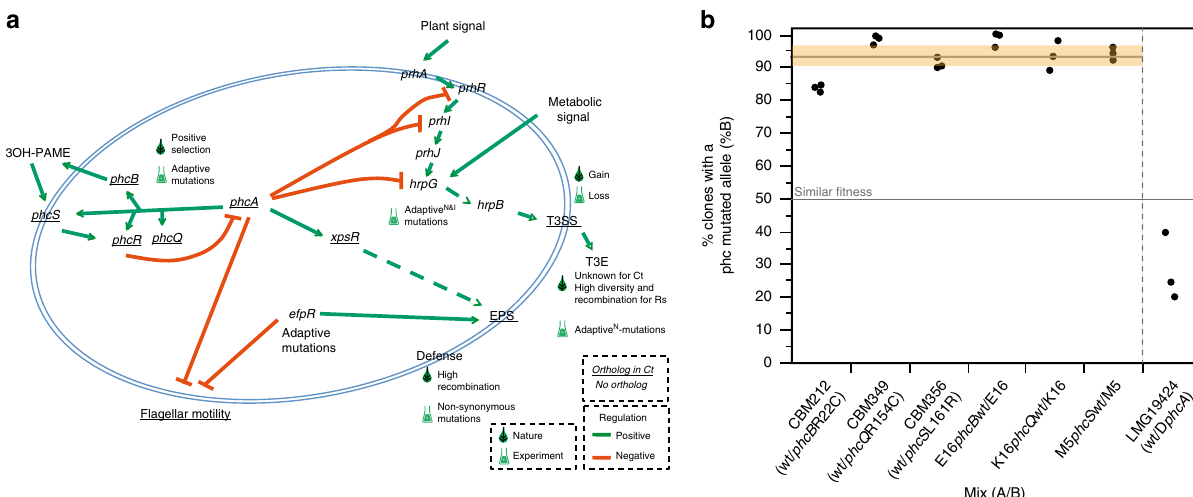
Fig. 4 Virulence factors and regulatory pathways of R. solanacearum and their evolution in the evolution experiment. a Schema of the major virulence factors and regulatory pathways mentioned in this study and their role in R. solanacearum (adapted from ref. 38 ). Adaptive N and adaptive I represent the presence of adaptive mutations for nodulation (N) and infection (I), respectively. Underline, genes or factors present in C. taiwanensis . The results of the enrichment analyses are in Supplementary Data 6, 8, and 9. b Adaptive nature of the Ralstonia phc alleles evolved in the experiment and the recruitment of PhcA for symbiosis in the natural symbiont C. taiwanensis LMG19424. Each dot represents an independent experiment. The horizontal gray line represents the average fi tness of the evolved phc genes relative to the wild type. The horizontal orange rectangle indicates the 95% interval of con fi dence for the mean. The results for phc are signi fi cantly different from the expected under the hypothesis that both variants are equally fi t (horizontal line at 50%, P < 0.005, Wilcoxon test). The mean for the analysis of the mutant of PhcA (25%) is smaller than 50%, although the difference is at the edge of statistical signi fi cance ( P = 0.0597, two-side t Student ’ s test). The codes of the clones correspond to those indicated in Fig.